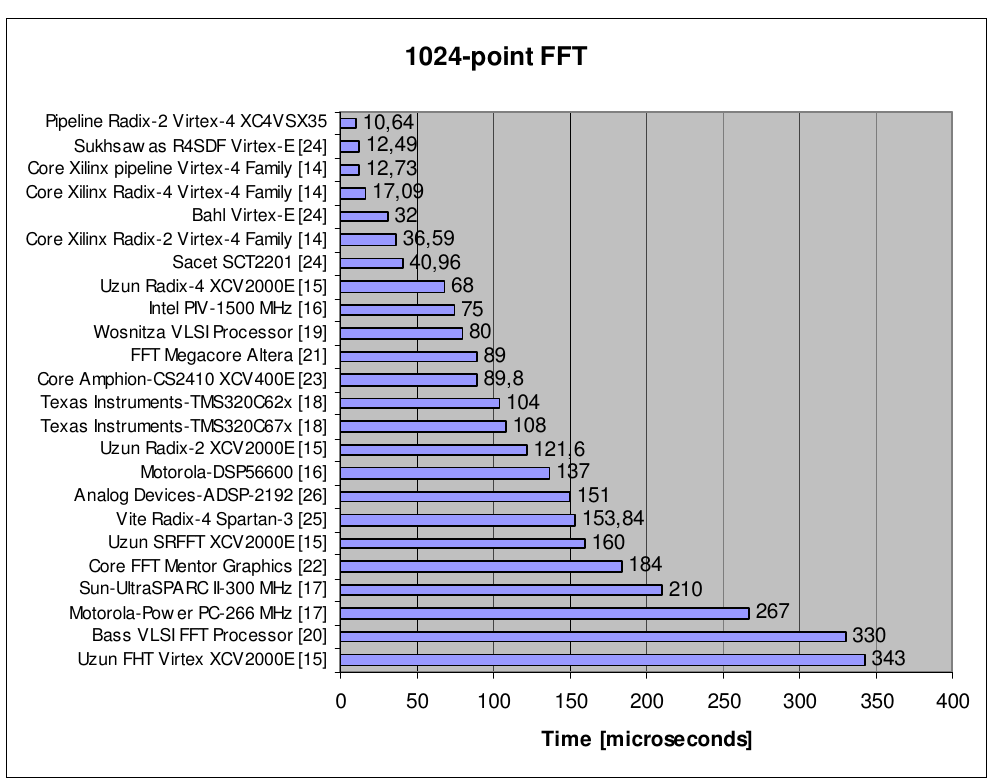
Figure 8. Execution times in microseconds for various algorithms of 1024-points FFT using different